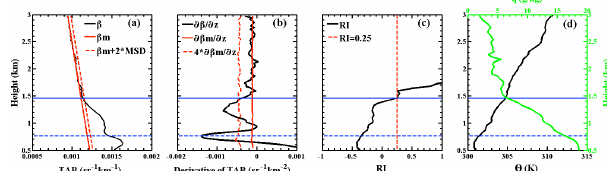
Figure 4. Illustrations of the MPL BLH and MLH identification methods for oceanic measurements (23:30, Mar 03, 2007): (a) TAB; (b) TAB gradient; (c) RI; (d) potential temperature and mixing ratio. The blue solid line in each figure denotes the Sonde derived BLH, and the blue dashed line denotes the MPL derived MLH.